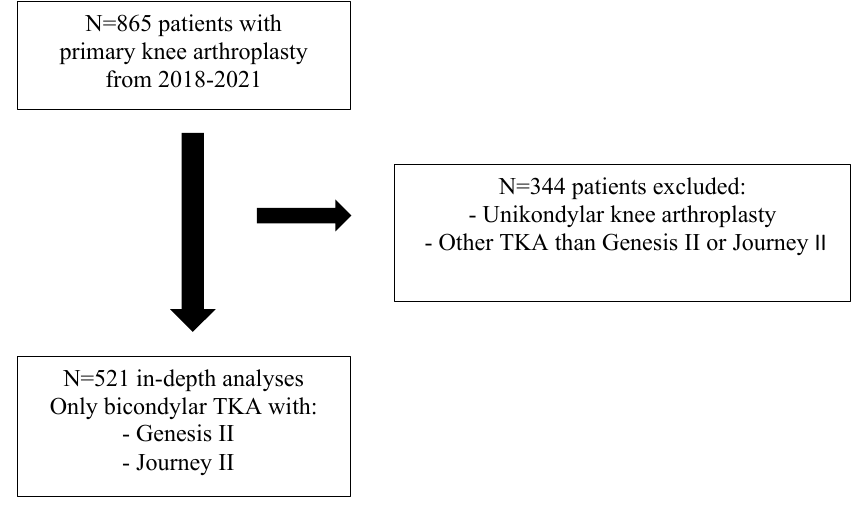
Figure 2. Recruitment process.